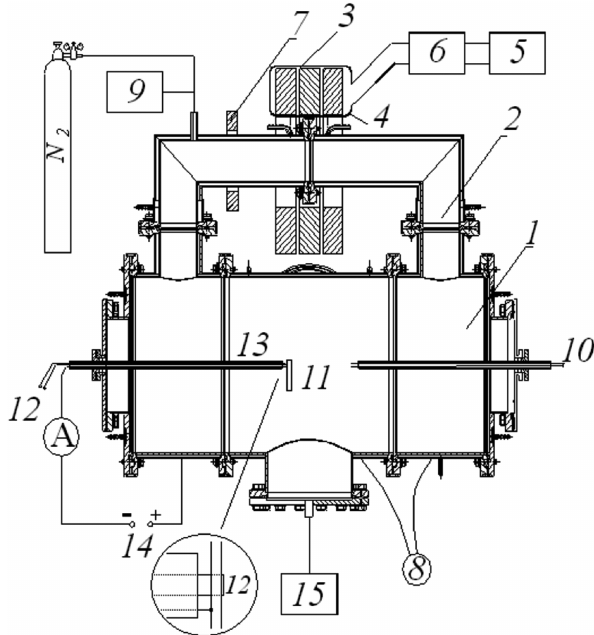
Figure 1: Experimental setup. 1 – Gas discharge chamber (internal diameter of 230mm), 2 – U-shaped part of the discharge chamber (ID of 40mm), 3 – ferrite cores, 4 – inductor (ICP coil), 5 – power supply (50 – 100 kHz, 500 V), 6 – matching network (variable LC circuit), 7 – current transformer (Rogowsky coil), 8 – voltmeter, 9